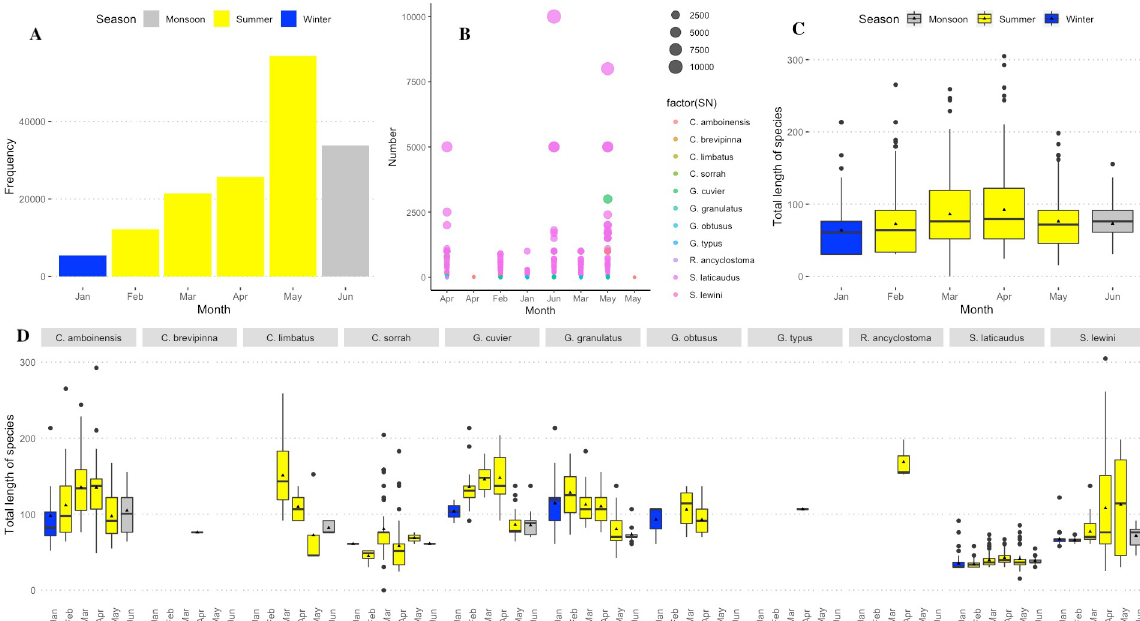
Fig 6. Seasonality: (A) Relative frequency of recorded specimens of elasmobranchs per month of the study period, ( B ) species-specific frequency of landing for each month, where the size of the circle denotes the number of bulk landings in a single day, ( C ) overall range of length of landed elasmobranchs in each month, and ( D ) length-specific landing for each species per month of the study period.